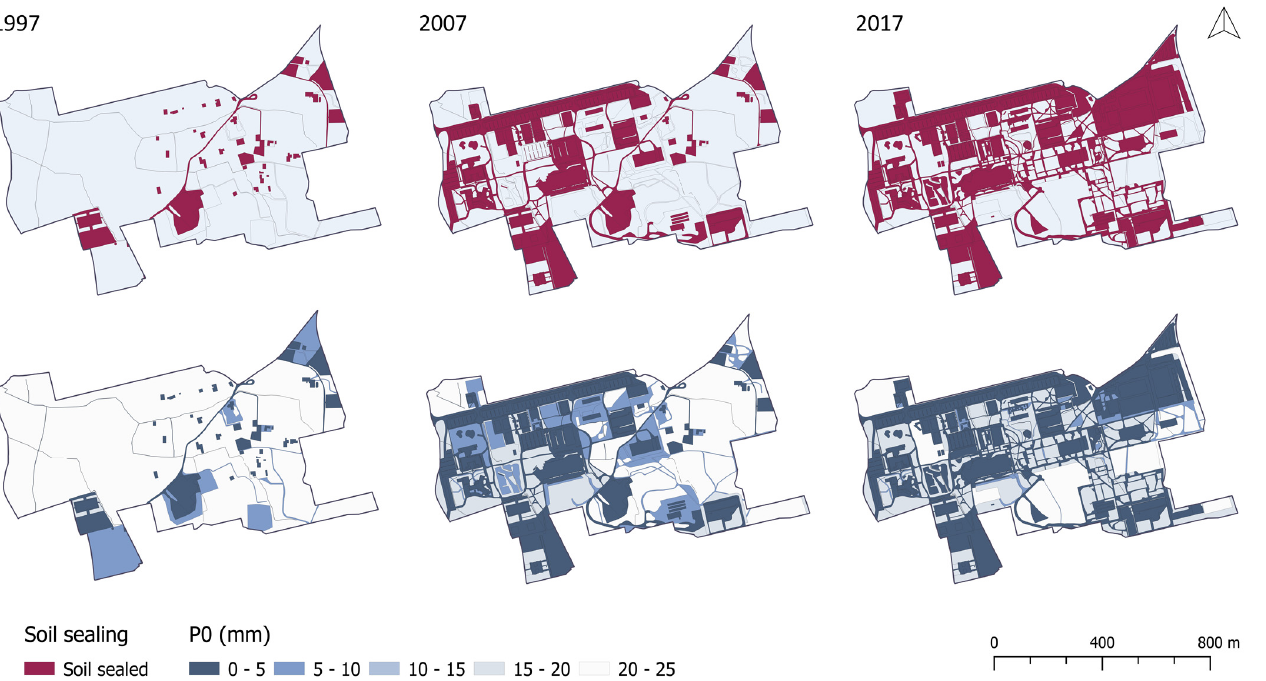
Figure 5. Spatial variability of soil sealed and initial P 0 values between 1997 and 2017.